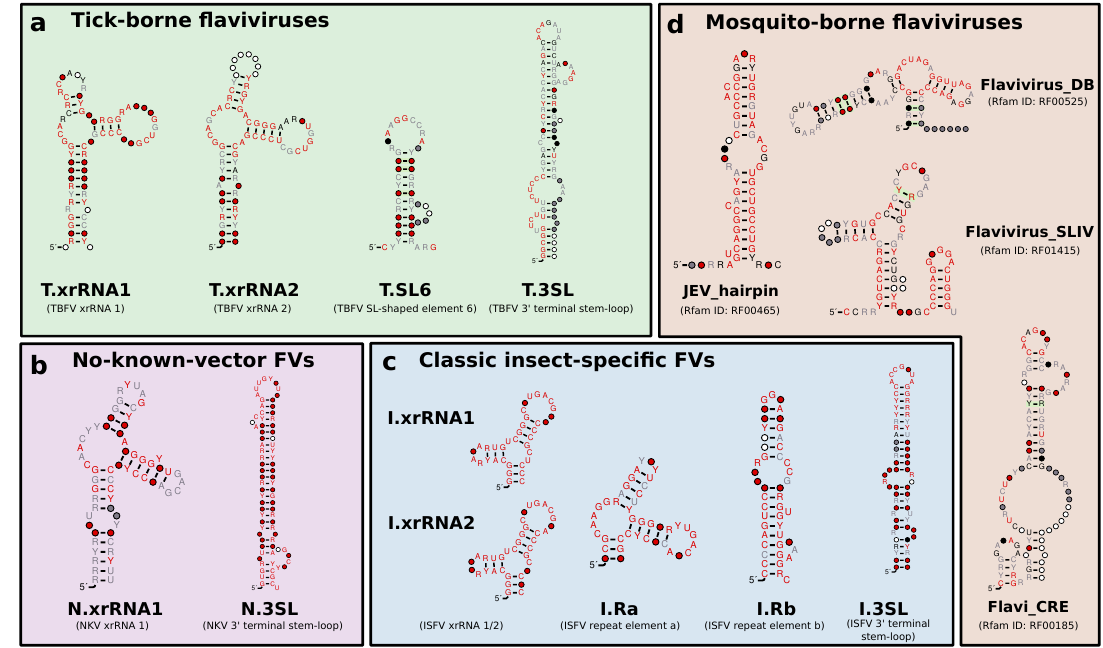
Figure 2. Overview of consensus structures of all CMs used for the annotation of flavivirus 3 (cid:48) UTRs. TBFV, ISFV, and NKV elements were refined from published experimental data (T.xrRNA1/2, I.xrRNA1/2, N.xrRNA) or identified computationally (T.SL6, I.Ra, I.Rb as well as all 3 (cid:48)